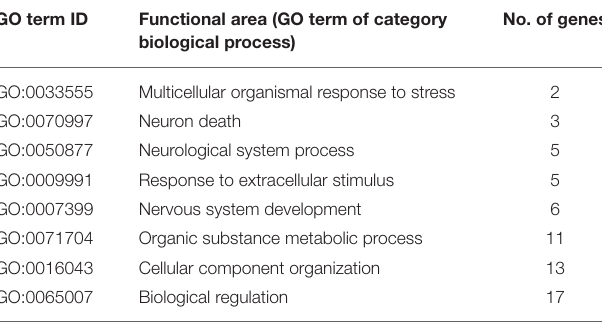
TABLE 4 | Functional areas representing the genetic background of hereditary insensitivity to pain presented in a polyhierarchy of GO terms with a maximum of certainty, information value, coverage and conciseness (Ultsch and Lötsch,